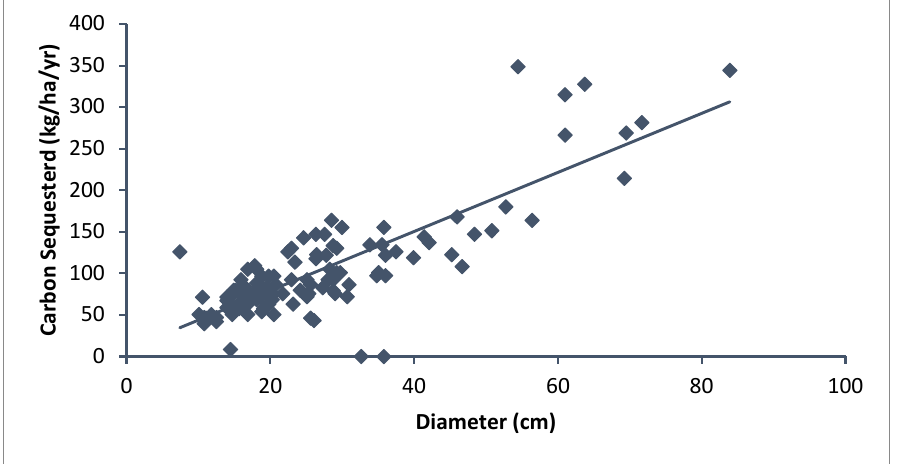
Figure 1. The relationship between carbon sequestered and stem diameter.